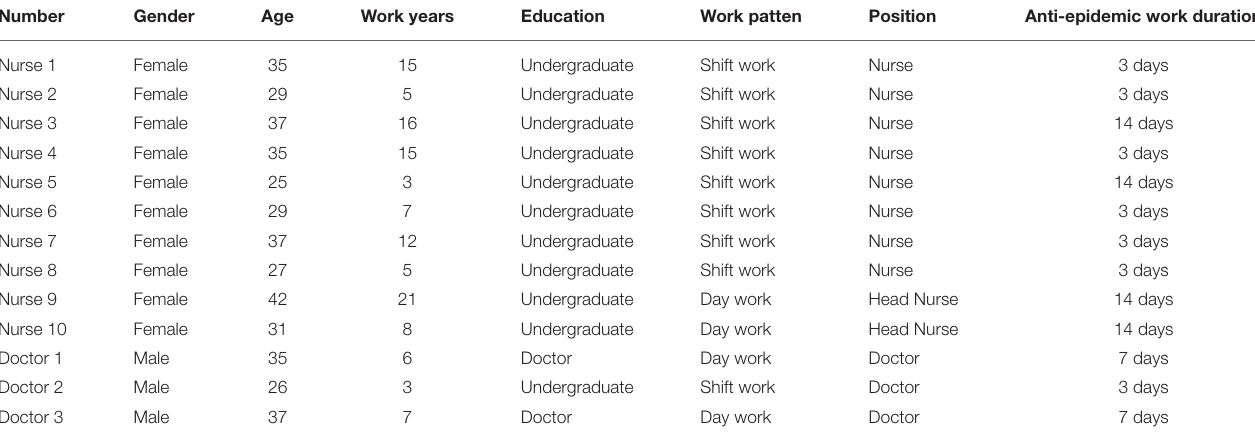
TABLE 1 | Participant information.